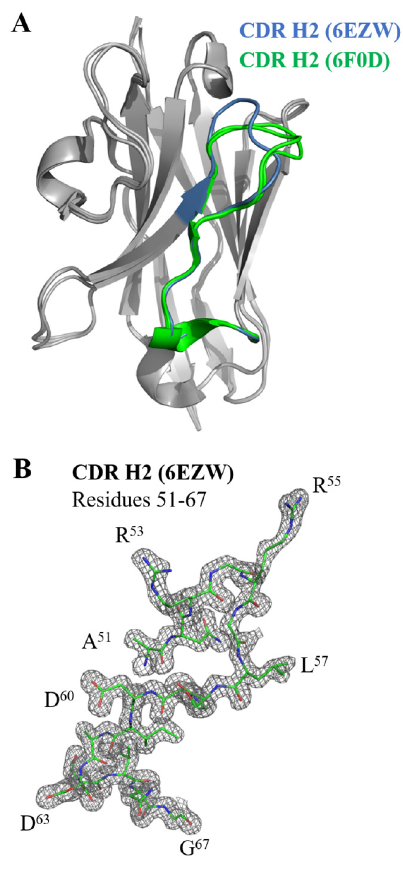
Figure 6. Structural comparison of BCD090-M2 crystallized in different space groups. A ) the three structures, 6EZW, 6F0D chain A, and 6F0D chain B, were superimposed, the structural alignment was based on C α atoms of framework regions. CDRs H1 and H3 showed little structural variation, while CDR H2 adopted different conformations in 6EZW and 6F0D, which are shown in blue and green color. B ) Electron density map (F-obs, Phi-model, 1.0 σ ) for CDR H2 (residues 51-67) of 6EZW. The quality of electron density maps allowed us to unambiguously trace the loop and place amino- acid side